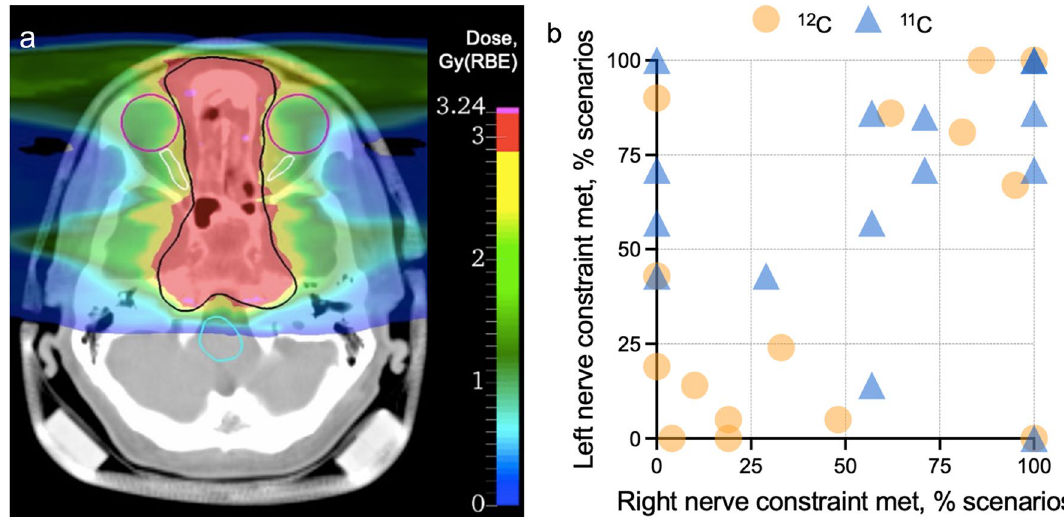
Figure 2. Treatment planning outcome for the adenoid cystic carcinoma patients. ( a ) Example of the double- field 11 C dose distribution and planning contours. Black – tumor CTV; magenta – eyes, white – optic nerves, turquise – brainstem. Color bar represents the dose distribution (red color corresponds to the prescribed CTV dose of 3 Gy(RBE)). ( b ) Patient-by-patient treatment planning outcome in terms of exceeding the dosimetric constraint for the optic nerves (2.46 Gy(RBE) to 0.03 cm 3 of the organ). Each point corresponds to the percentage of treatment uncertainty scenarios when the constraint is met. Orange circles represent 12 C plans